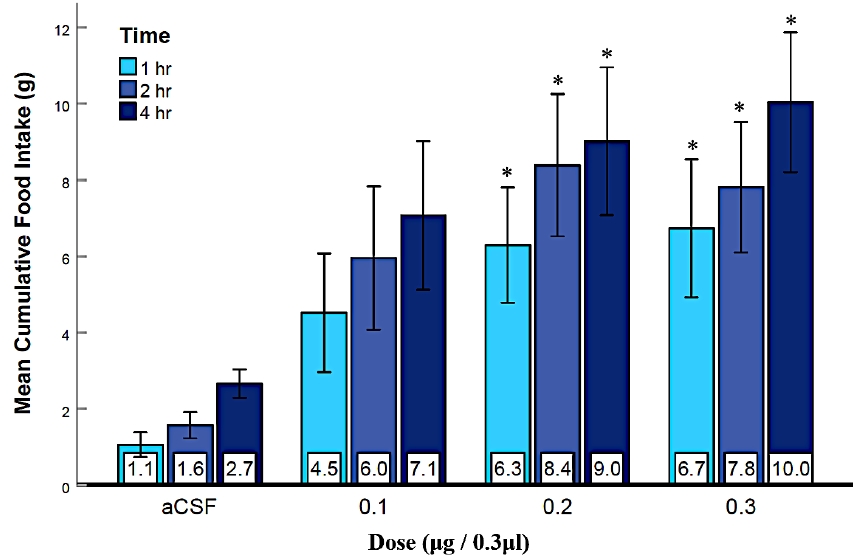
Figure 2. Muscimol injection into the LS during the light phase rapidly elicited eating. Error bars represent mean ± SEM; n = 15; mean values are shown at the bottom of each bar. * indicates significant differences at p < 0.05 compared to the aCSF group at matched